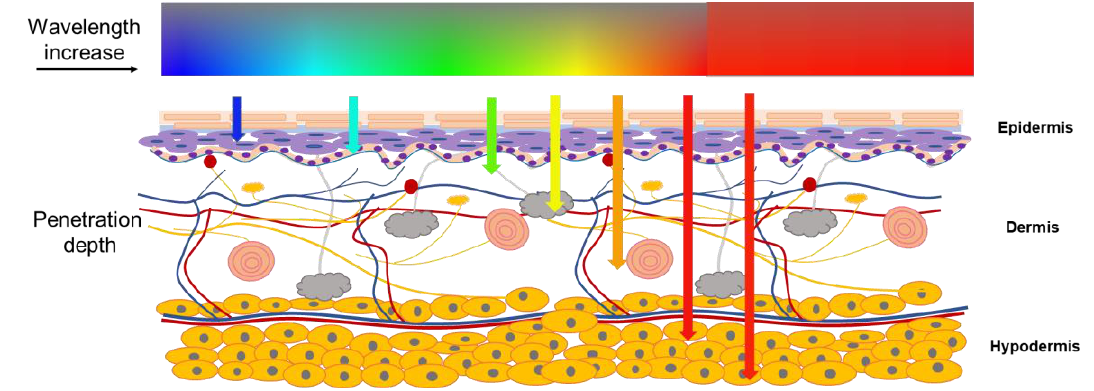
Figure 3. Varying depths of light penetration on tissue.